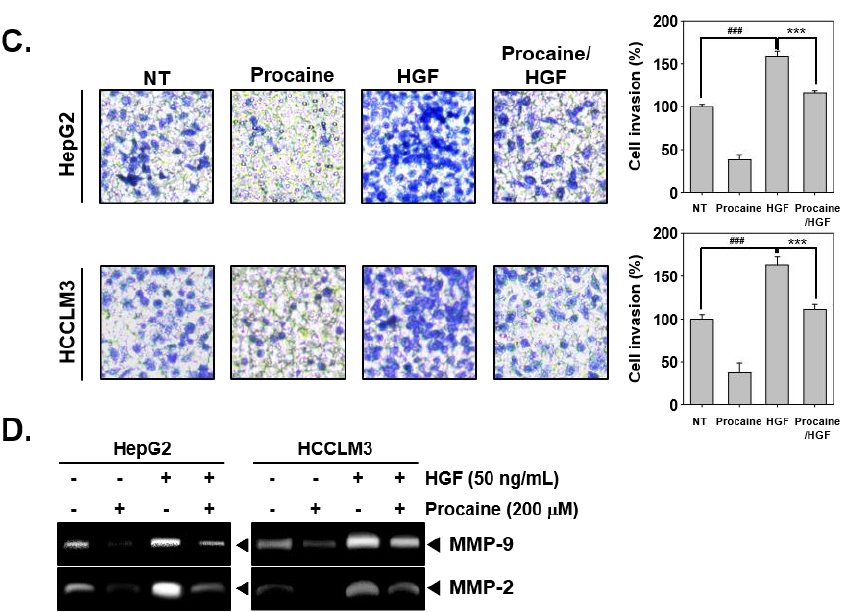
Figure 2. Influence of procaine on invasion and migration. ( A ) HepG2 and HCCLM3 cells were exposed to procaine (200 μM) or HGF (50 ng/mL) for 24 h. Morphological changes were then observed under the microscope. ( B ) HepG2 and HCCLM3 cells were exposed to procaine or HGF for 24 h, and then a wound healing assay was carried out (scale bar: 40X). The space between the lanes was measured at the beginning of the experiment and at 24 h of incubation. Data represents mean ± SD. ### p < 0.001 vs. non-treated cells. ( C ) The invasiveness of HCC cells was measured using the Boyden chamber assay. Data represent mean ± SD. ### p < 0.001 vs. non-treated cells and *** p <0.001 vs. HGF treated cells. The results shown are representative pictures of three independent experiments. ( D ) Gelatinolytic activity of MMP-9 and MMP-2 was determined by gelatin